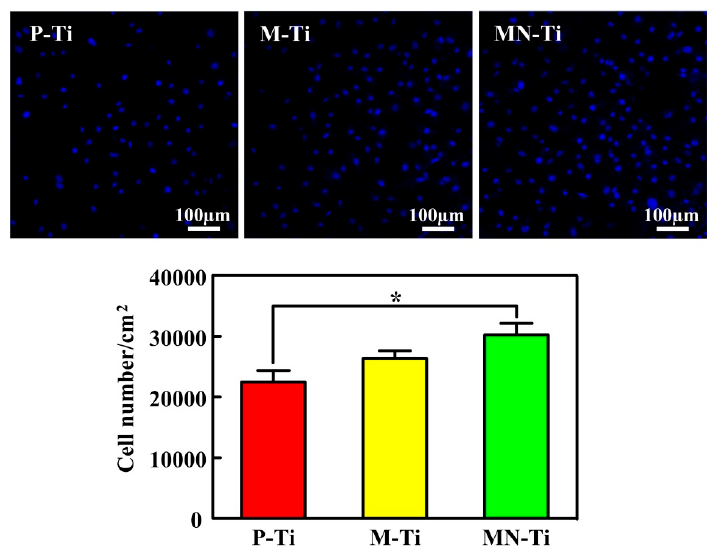
Figure 8. Initial adherent MC3T3 cell numbers measured by counting cells stained with Hoechst 33258 under a fluorescence microscope after 24 of incubation. * p < 0.05.